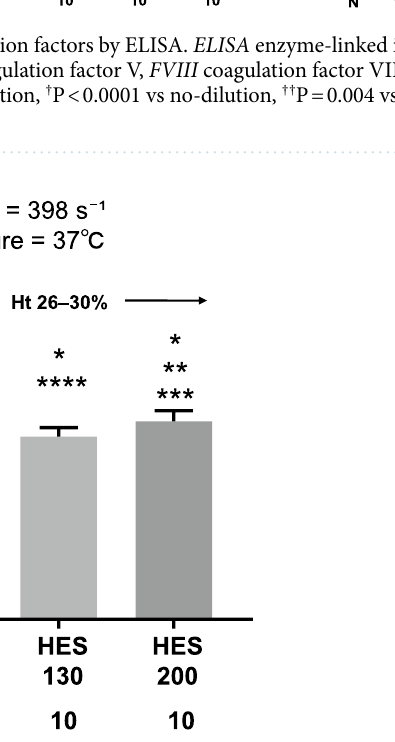
Figure 6. Shear viscosity measurement by rheometer. PS physiological saline, HES130 6% hydroxyethyl starch 130/0.4 in PS (6% Voluven), HES200 10% hydroxyethyl starch 200/0.5 in PS (10% Pentaspan). *P < 0.0001 vs no-dilution, **P < 0.0001 vs PS, ***P = 0.01 vs HES130, ****P = 0.032 vs